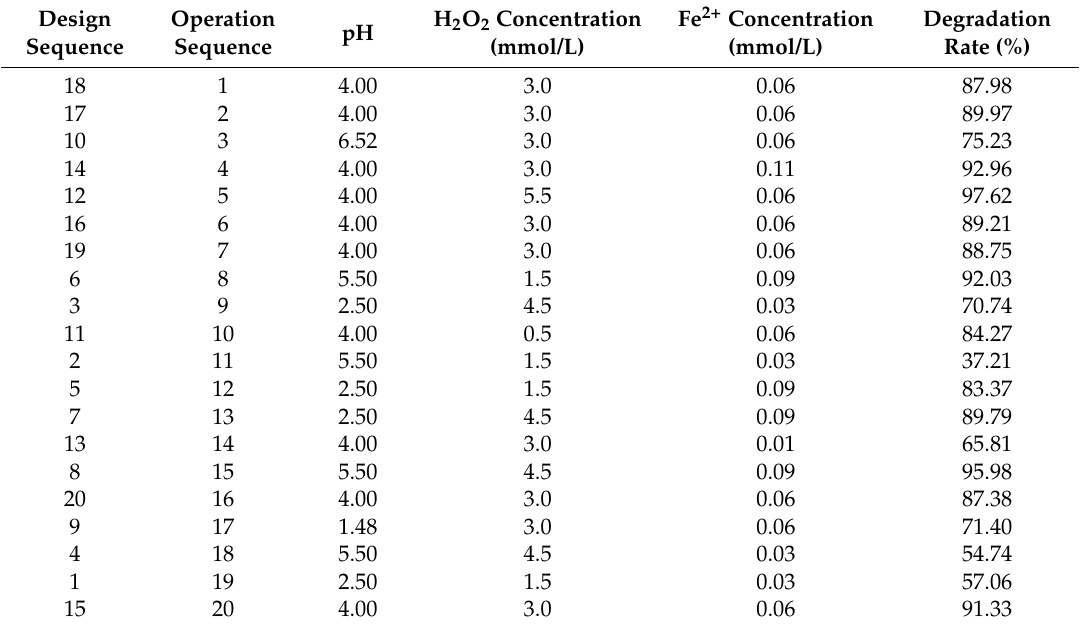
Table 2. Central composite design experimental groups.